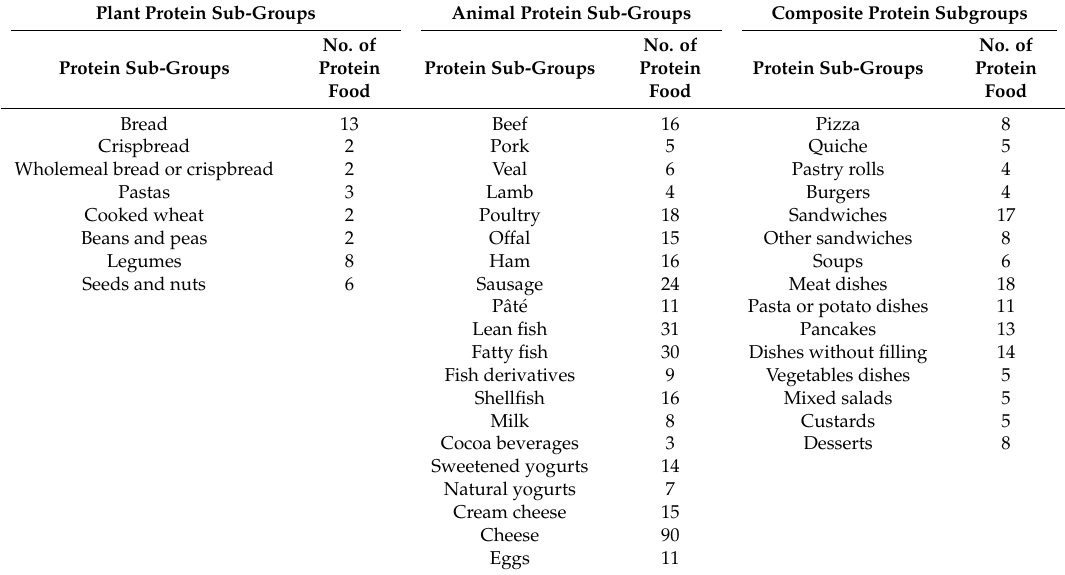
Table 1. Protein food sub-groups selected to identify dietary protein patterns and number of protein foods in each